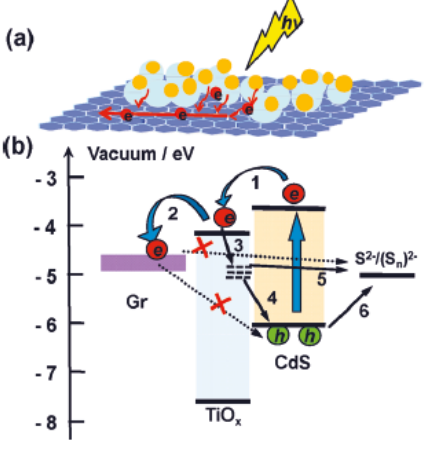
Figure 7. Schematic representation of photo-generated electron transfer processes in a layered reduced graphene oxide/quantum dot (QD) structure with TiO the Energy Band Diagram ( b ) showing the main electronic processes at the interface in QDs: (1) Electron injection; (2) electron transfer; (3) Trapping of the electron at surface states; the two charge recombination pathways of trapped electron recombination with; (4) the hole at the valence band of QDs and; (5) the oxidized redox couple; (6) hole extraction. The recombination between the electron at Fermi level of rGO and the hole at the valence band of QDs and the oxidized redox couple was inhibited by TiO copyright permission from reference [111]. Copyright © 2011, American Chemical